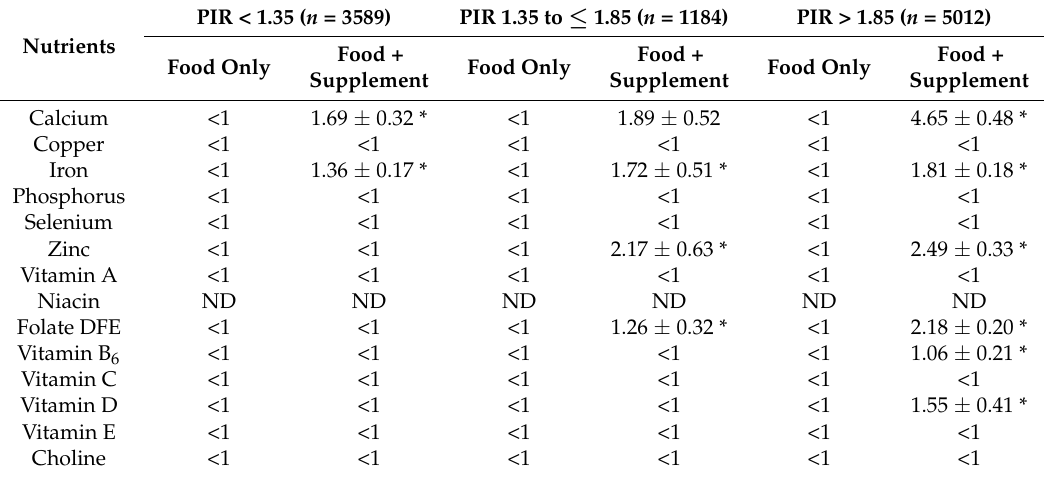
Table 5. Percent adult (19+ years old) population exceeding Tolerable Upper Limit of intake (UL) of nutrients from foods and foods + dietary supplements by Poverty-Income-Ratio